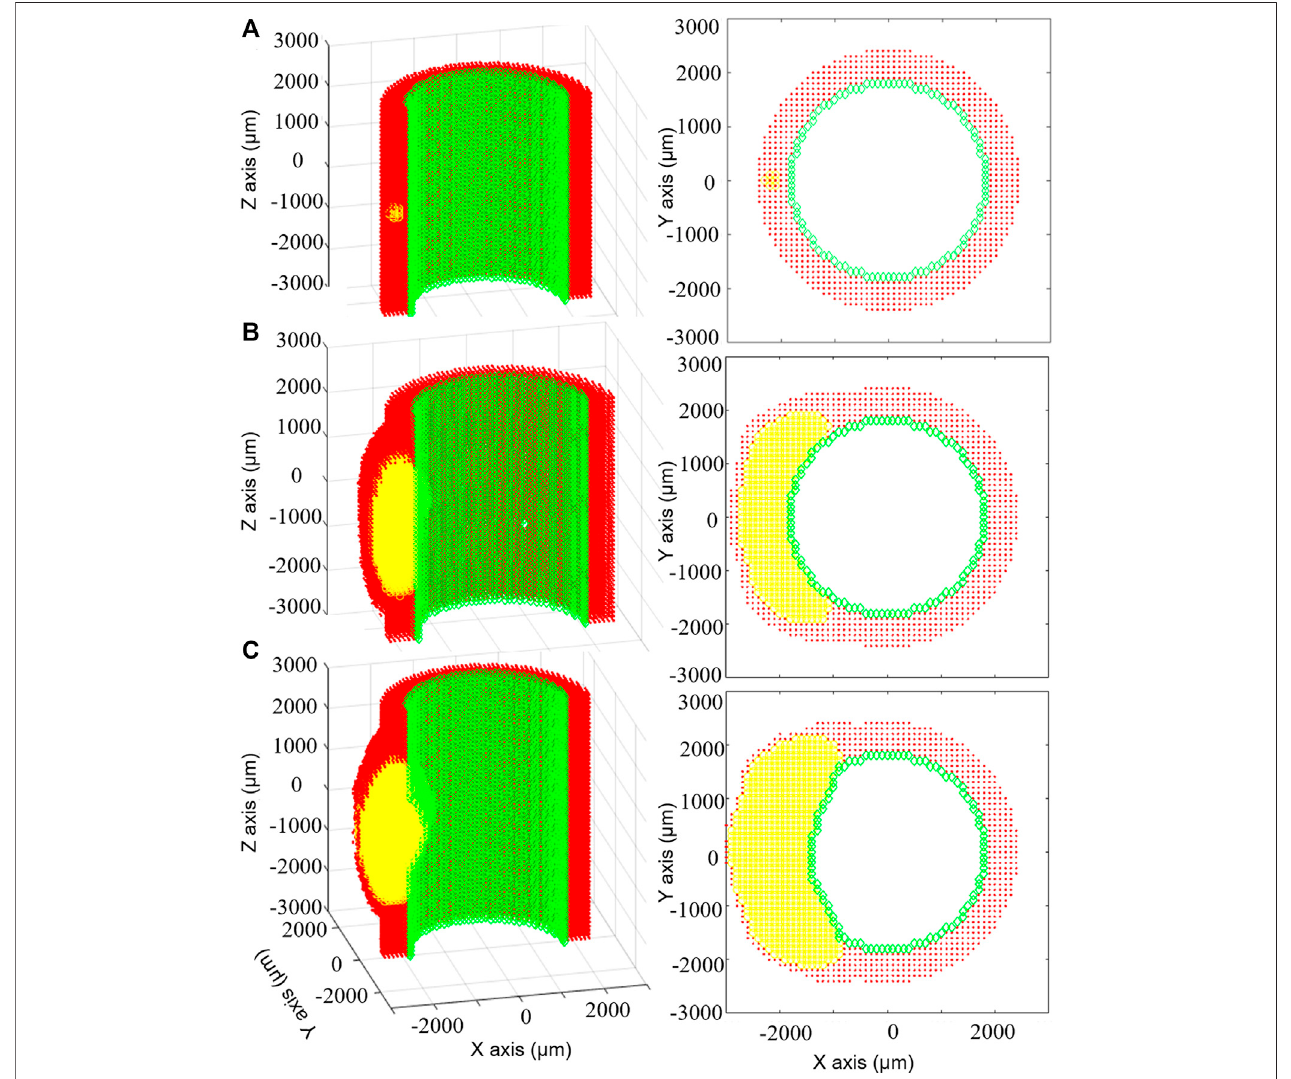
FIGURE 5 | Results of the multiscale computational fl uid dynamics – agent-based model (CFD-ABM) framework of atherosclerosis by Bhui and Hayenga (2017). ThetemporalevolutionoftheABMgeometryfromtheinitialcon fi guration (A) tothecon fi guration at6 months (B) andat7 months (C) isshown,forthelongitudinal (left) andtransverse (right) views,withtheendothelialcellsingreen,thearterialcellsinredandleukocytesinyellow.Theinitialcondition (A) ischaracterizedbythepresenceof 15leukocytesinthearterialwall.Until6 months (B) ,thankstothecompensatoryGlagov ’ sremodeling,theplaquegrowthdeterminedanoutwardremodeling,while preserving the lumen area. At this point, the plaque area is 40%. At 7 months (C) , the plaque growth provokes a reduction of the lumen area. Reprinted with permission from Bhui and Hayenga (2017) (http://creativecommons.org/licenses/by/4.0/).